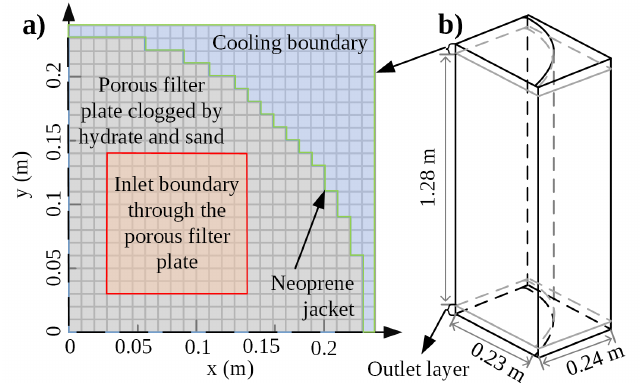
Figure 4. Simulation domain with numerical grid employed for the numerical simulations of the LARS experiment: ( a ) grid and inlet boundary geometry (porous filter plate at top) with cooling boundary outside the neoprene jacket; ( b ) model geometry of the sample chamber and cooling boundary with the outlet layer at bottom (not to